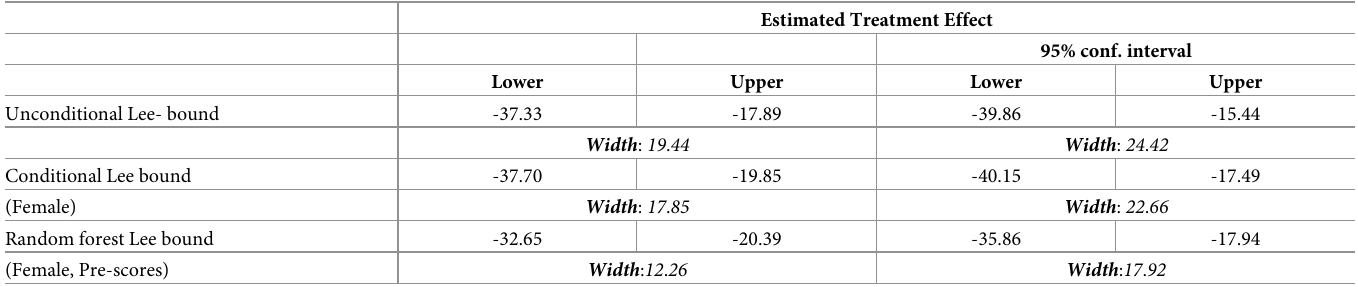
Table 1. Bounding estimation results.